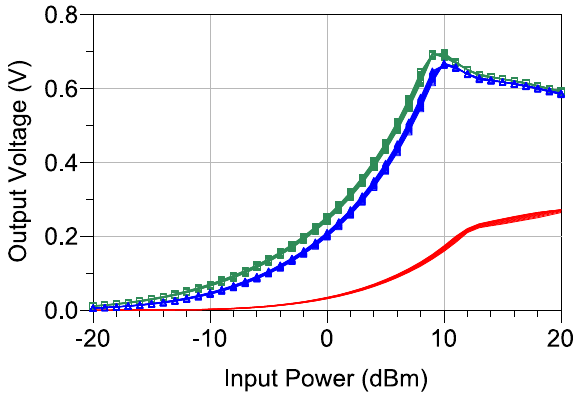
Figure 6. Output voltage versus input power with frequency sweep from 5 to 6 GHz when 𝑅 (cid:3013)(cid:3042)(cid:3028)(cid:3031) is 36 k Ω (green square line), 3.6 k Ω (blue triangle line), and 36 Ω (red solid line).